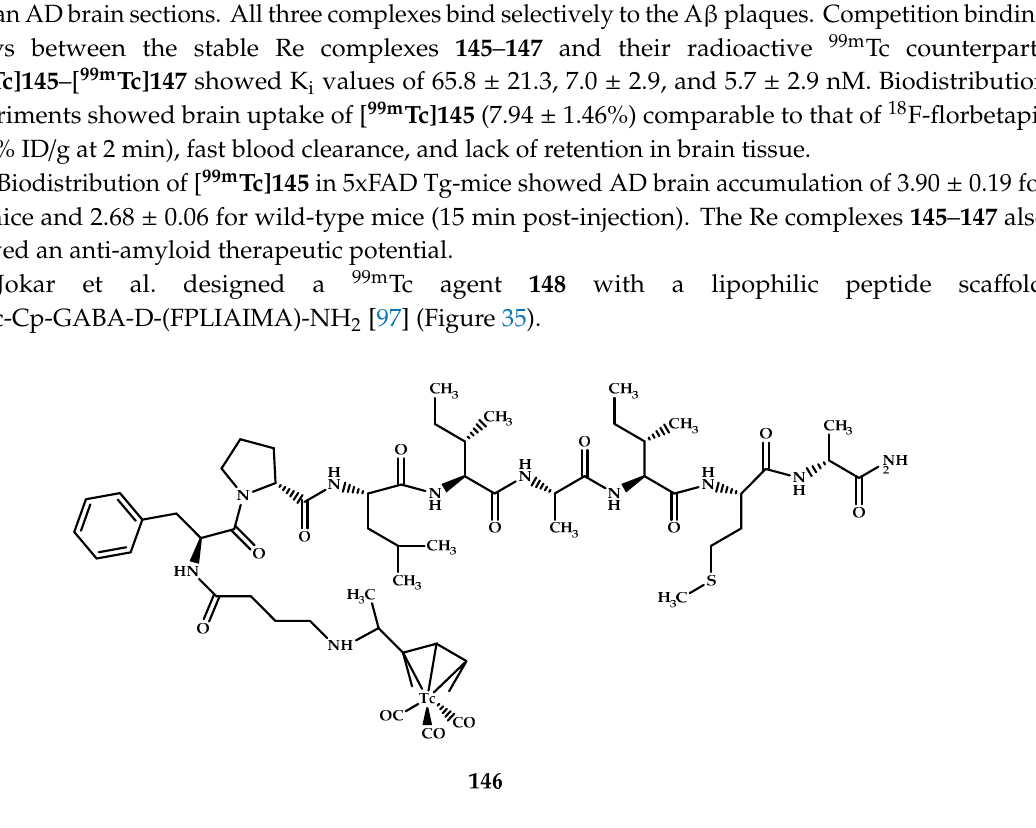
Figure 34. 99m Tc complexes [ 99m Tc]145– [ 99m Tc]147 and their corresponding Re analogues 145 – 147 designed for SPECT imaging of A β plaques .